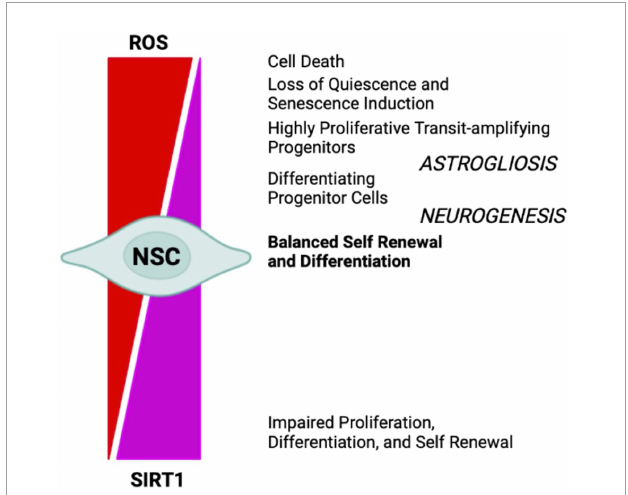
FIGURE4 NSCs cell-fate decision depends upon redox balance and SIRTs activity. High oxidizing conditions favor NSCs differentiation into astrocytes (astrogliosis), senescence, and cell death, whereas mild oxidative/reducing conditions favor neuron formation (neurogenesis), through a complex regulatory network modulated by SIRT1 expression and